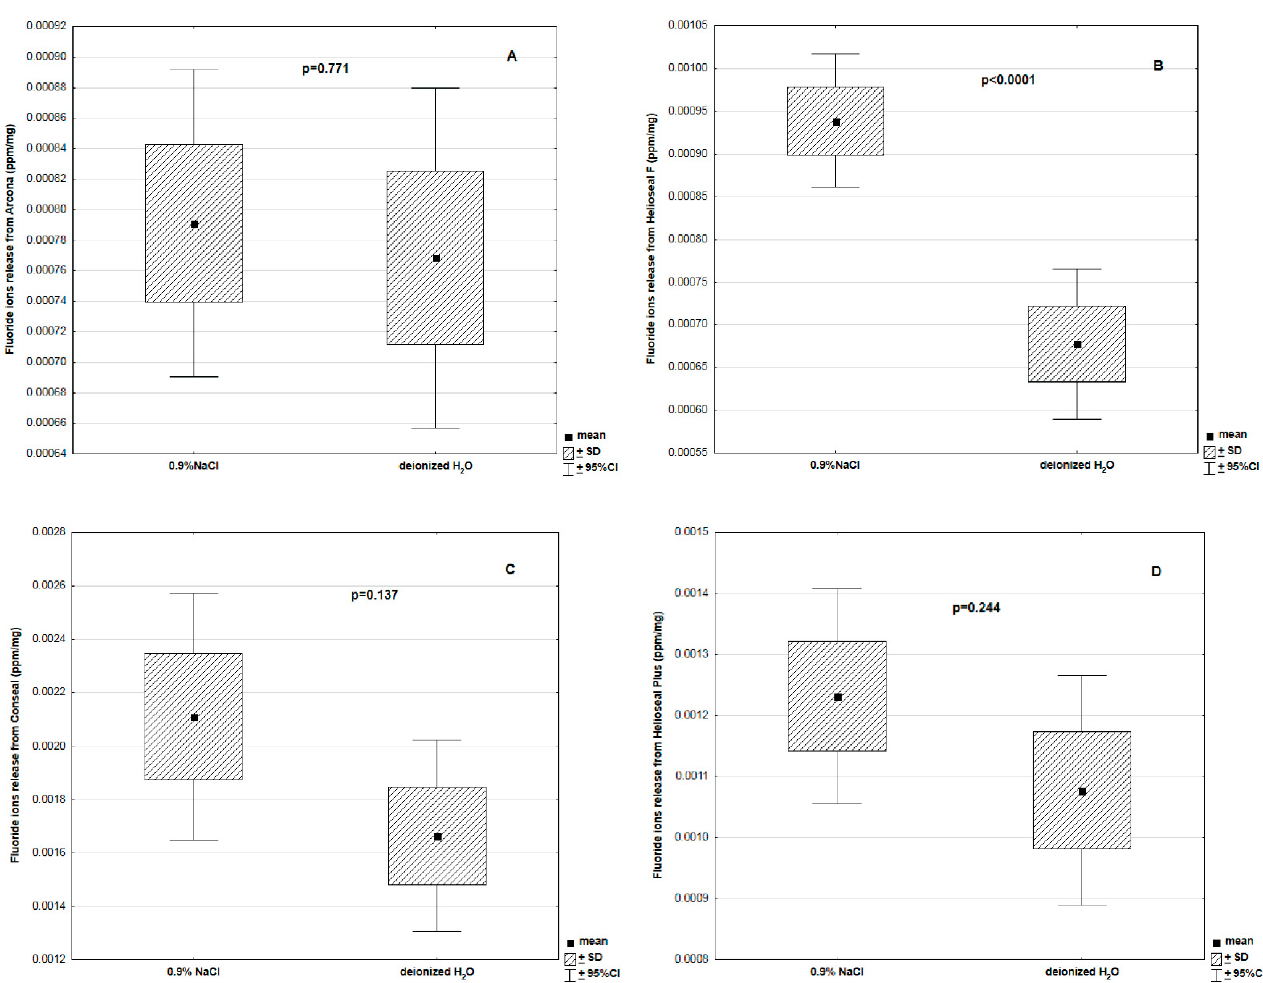
Figure 6. Fluoride ion release from different fissure sealants (( A )—Arkona; ( B )—Helioseal; ( C )—Conseal; ( D )—Helioseal Plus) into 0.9% NaCl and deionized water in a period of 336 h.